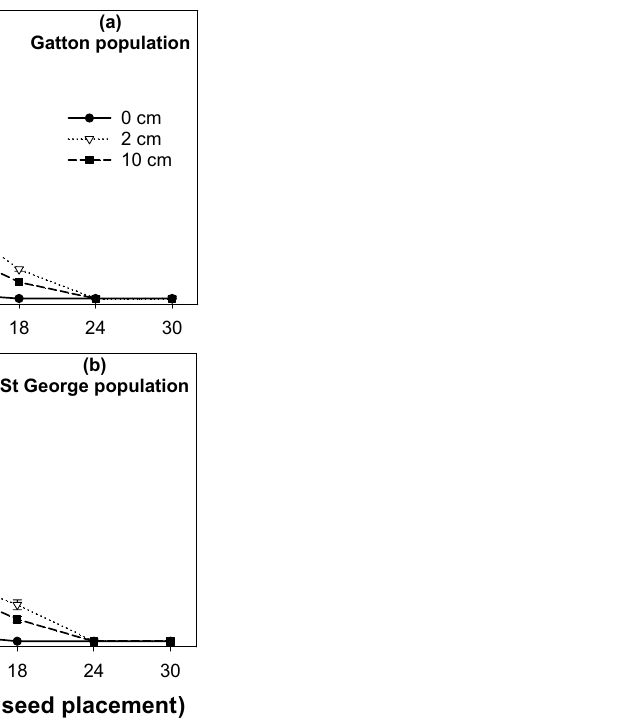
Figure 3. Seed persistence of Sonchus oleraceous from Gatton ( a ) and St George ( b ) locations placed in mesh- bags at 0, 2, and 10 cm depths, symbols correspond to mean and error bars are the standard error of means (n =